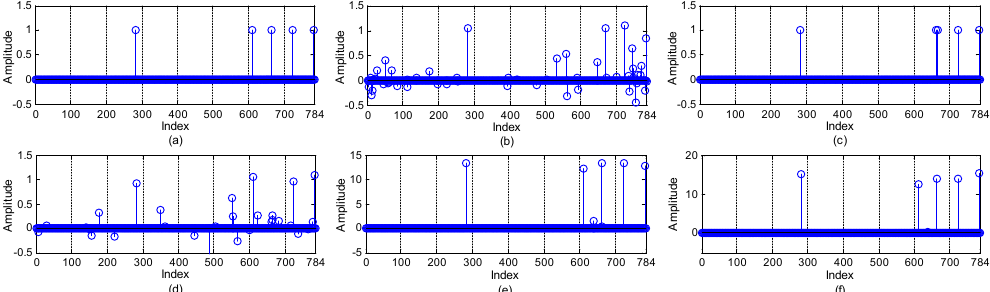
Figure 10. Comparison of the original location vector and the reconstructed sparse vectors of different DFL approaches. ( a ) the original location vector; The reconstructed sparse vector corresponding to ( b ) E-HIPA; ( c ) LCS; ( d ) DR-DFL; ( e ) ComDec ( F = 5); ( f ) ComDec ( F =